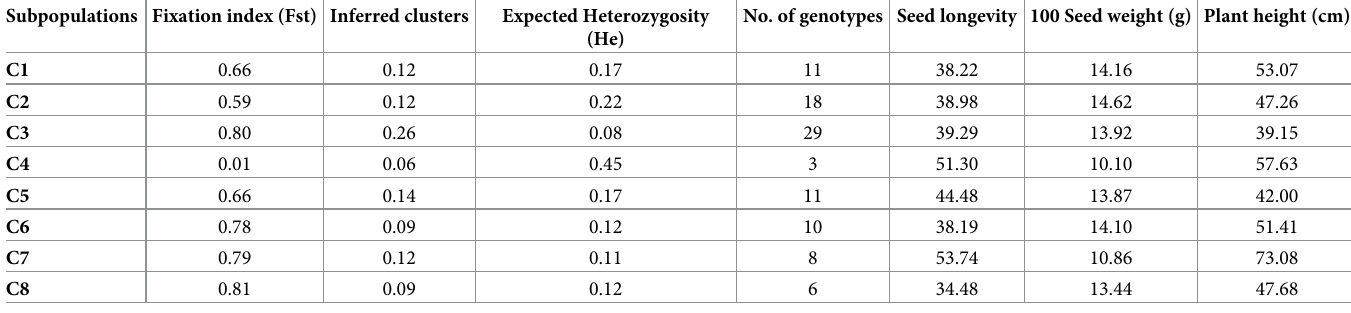
Table 3. Fixation index, expected heterozygosity and number of genotypes in eight sub groups of soybean genotypes derived from SNP population structure analysis. Subpopulations Fixation index (Fst) Inferred clusters